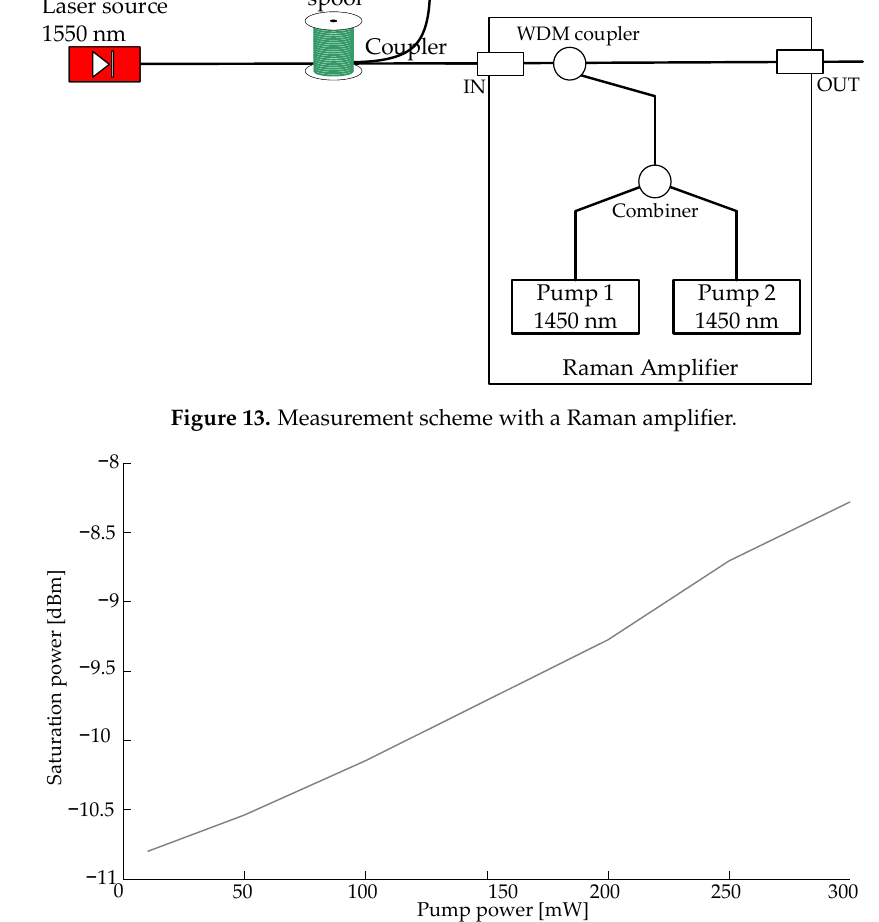
Figure 14. Dependence of the saturation power on the pump